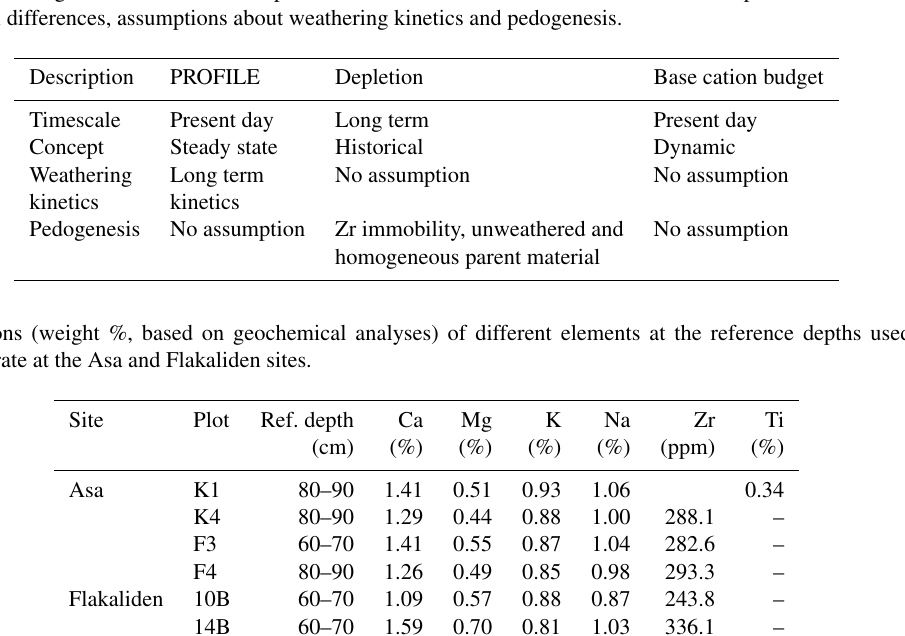
Table 2. A short description of characteristics of the three different approaches that are used in the study to estimate base cation release rates at the pedon scale using a harmonised set of input data. The difference between methods reflect expected differences due to different timescales, conceptual differences, assumptions about weathering kinetics and pedogenesis.